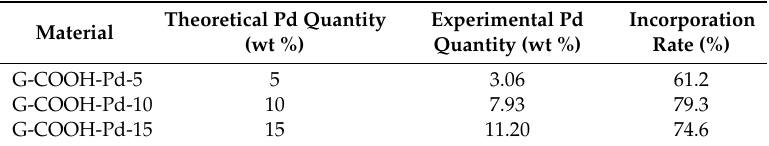
Table 1. Theoretical and experimental Pd (wt %) quantity and Pd incorporation rate (%) in